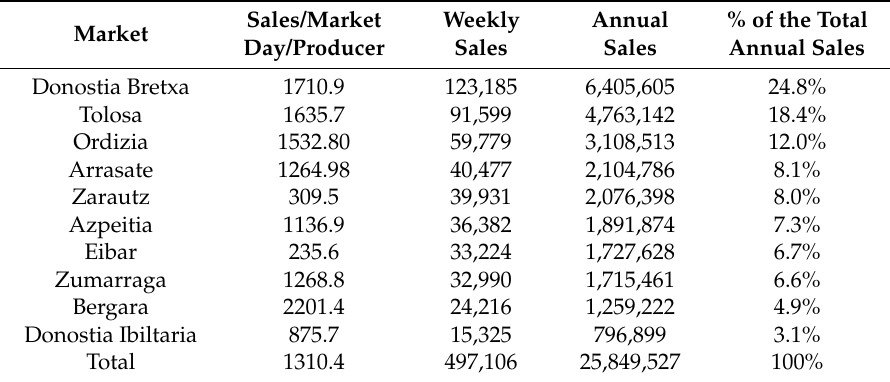
Table 4. Sales in markets according to consumers (in